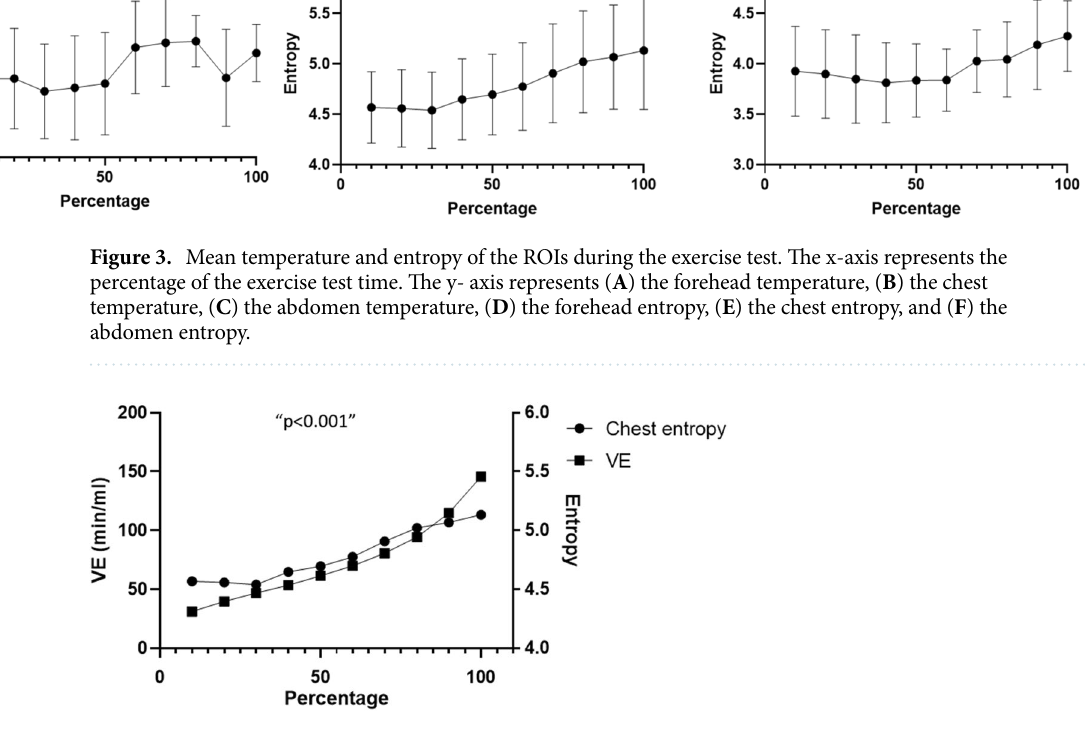
Figure 4. VE and entropy increases during the exercise test. The x-axis represents the percentage of the exercise test